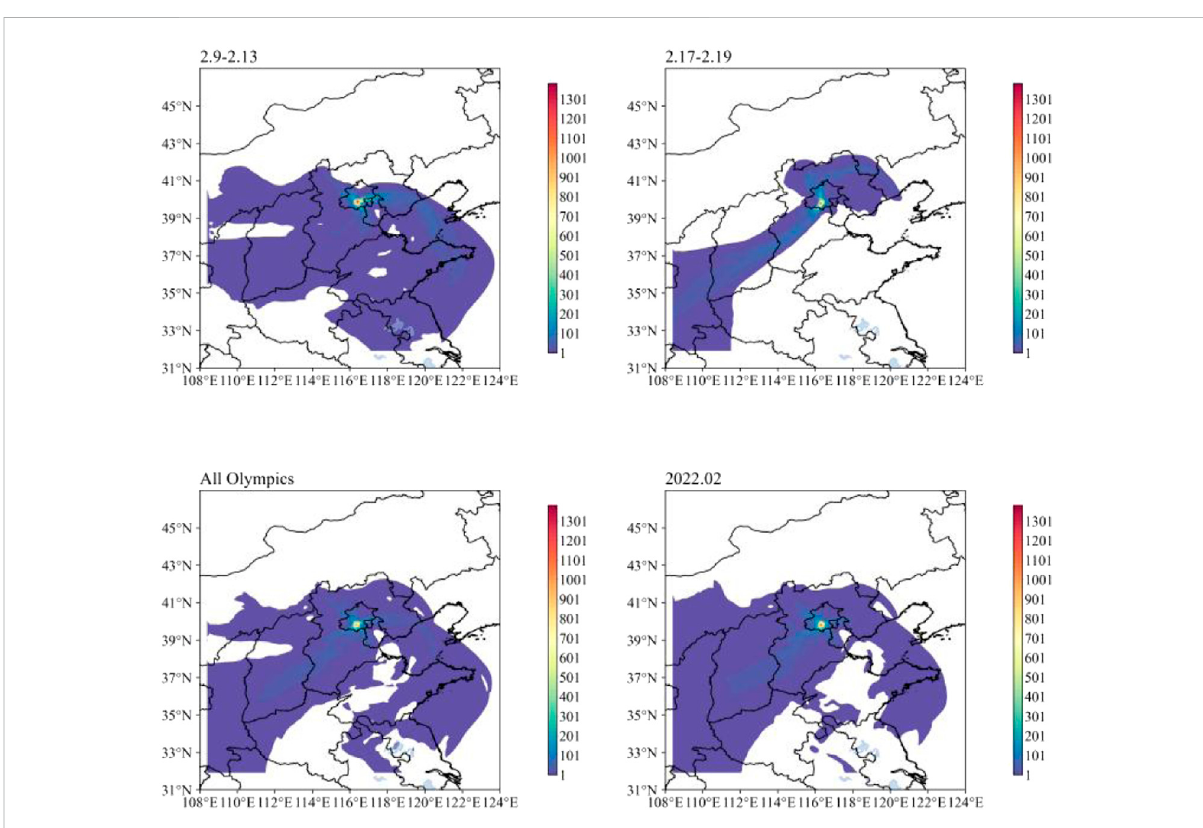
FIGURE 7 FLEXPART-WRF backward trajectory simulation of the entire Winter Olympics, 9 February to 13 February, 17 February to 19 February, and February 2022 48-h footprint distribution. The unit is s*kg/m 3 .